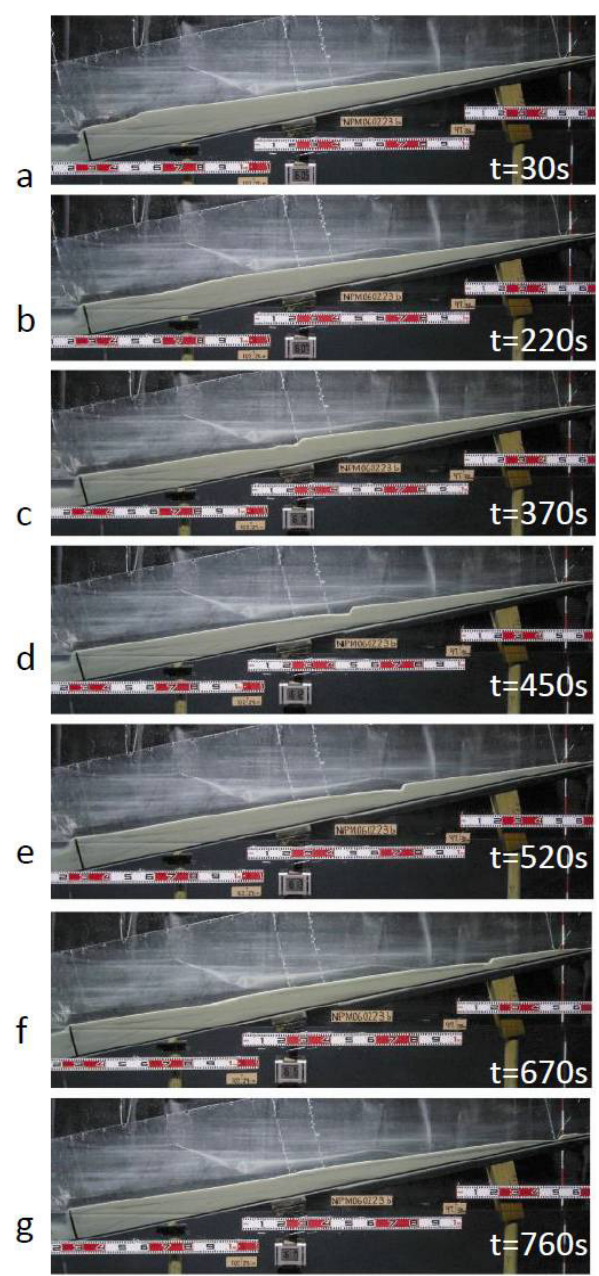
Figure 2. Sequential images of river profile in Run 3, illustrating the formation and upstream migration to the alluvial-basement transition of a knickpoint.